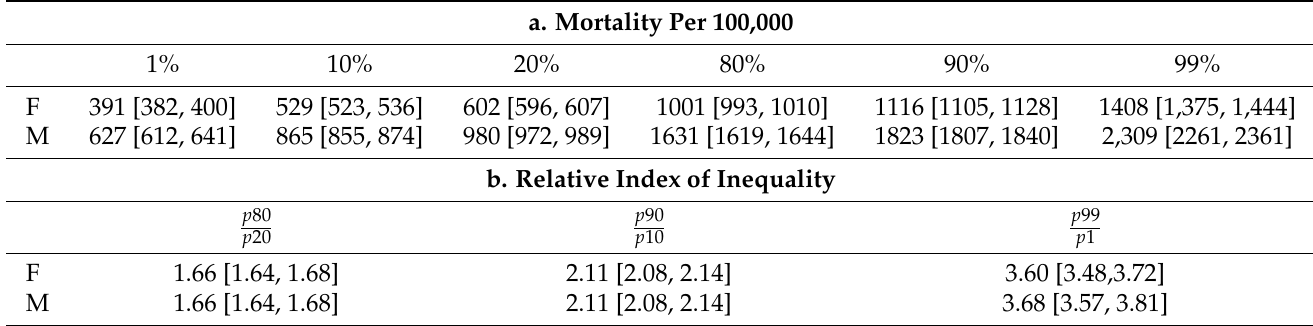
Table 5. County mortality rates, ages 55–64, by sex and select quantiles and the corresponding relative indices of inequality (posterior means with 95%